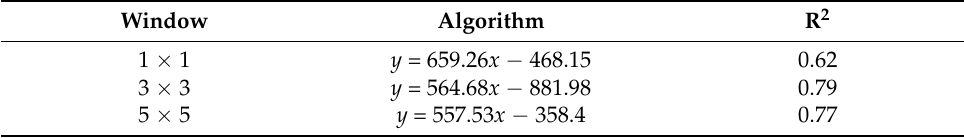
Table 2. Regression analysis for different windows.